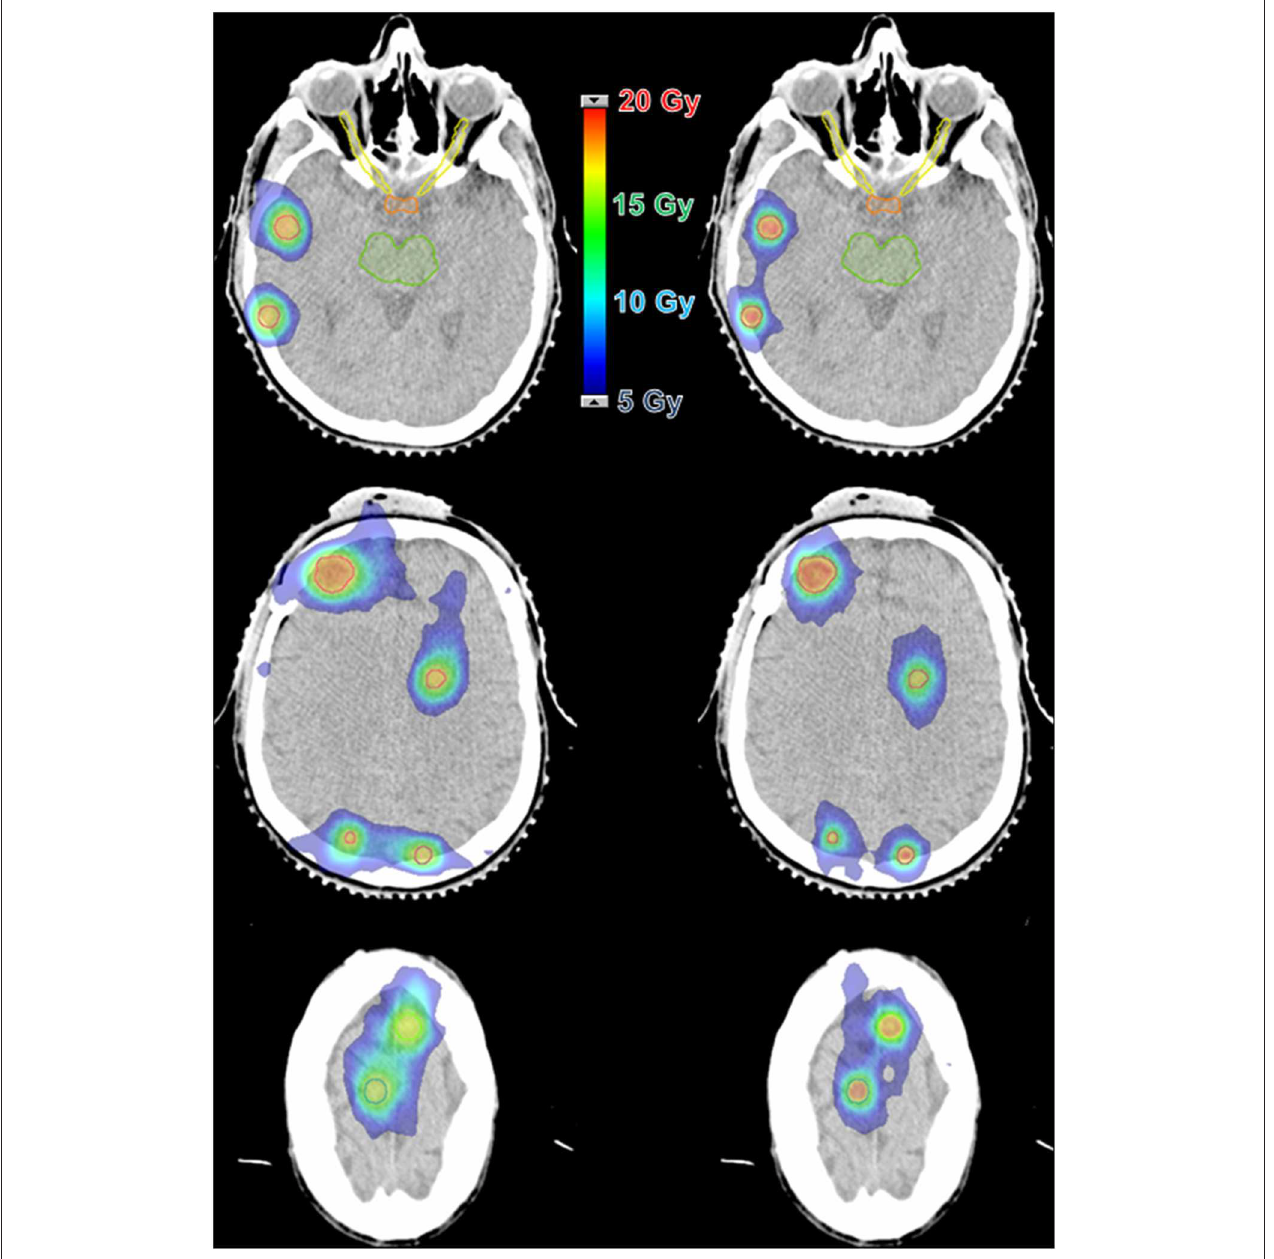
FIGURE 2 | Dose distribution comparison between two techniques for a case with 8 lesions and a prescription dose of 16Gy. (Left) 3D-CRT with 8 isocenters and 62 beams. (Right) VMAT with 1 isocenter and 6